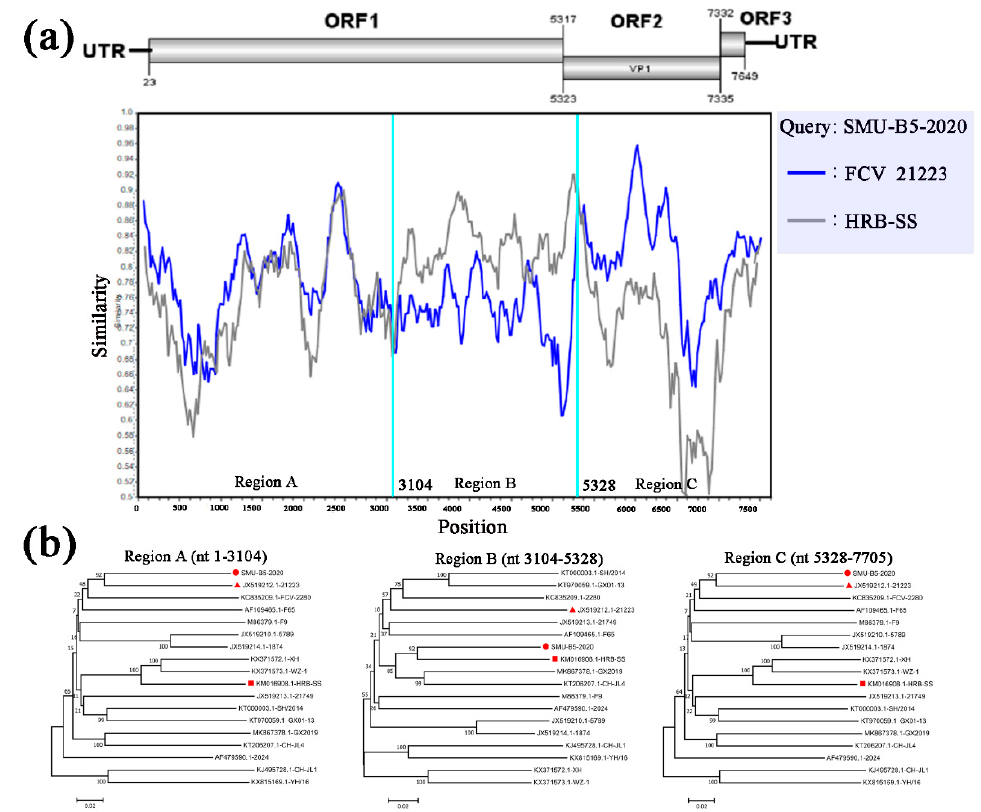
Figure 5. Full-length genome recombination analysis of SMU-B5-2020. ( a ) Genome scale similarity comparisons of SMU-B5-2020 (query) with FCV-21223 (blue) and HRB-SS (gray). The supposed recombination region is shown with red colors and the recombination breakpoints are marked at the bottom with nucleotide sites and viral genome structure referenced to FCV-21223; ( b ) phylogenetic trees based on every recombinant fragment within SMU-B5-2020 and 17 reference FCV strains are shown below the similarity plot. The strain SMU-B5-2020 is labeled with “red circles” and the putative recombinant parent strains are marked with “red triangles”.